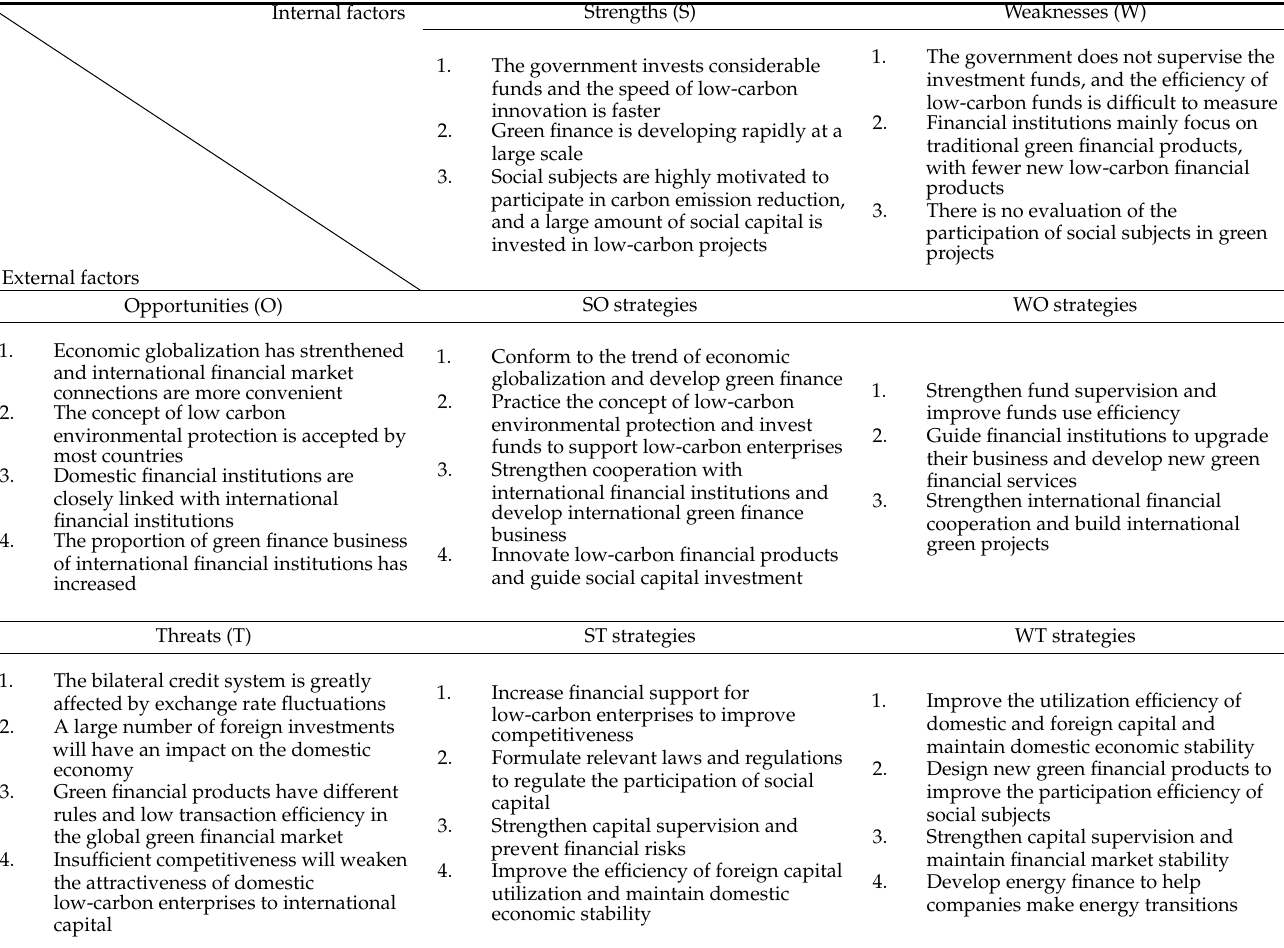
Table 2. SWOT analysis of financial measures to reduce carbon emissions in